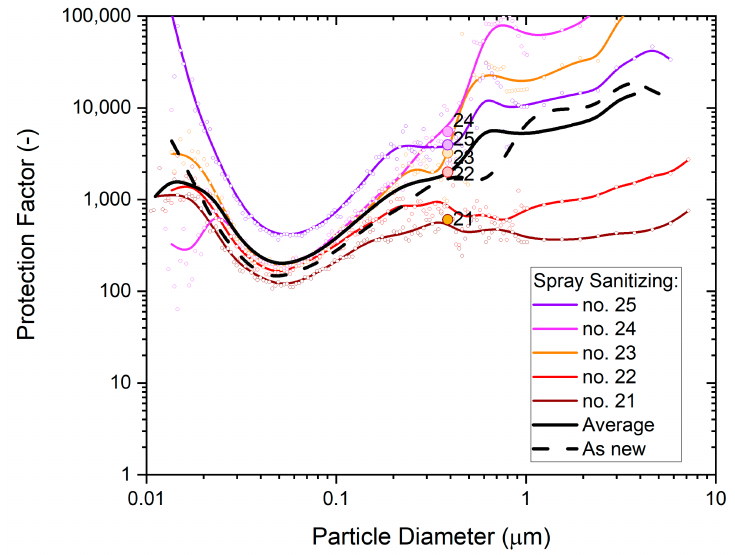
Figure 13. The particle size dependence of the protection factor of five P2-SD disposable respirator masks (Shanghai Da Sheng, box 3) after exposure to vapors from spray sanitizing; results from non-destructive testing are shown as circular dots with corresponding coloring at 0.39 µ m particle size. The average performance is shown by the black solid line and the performance of an unused mask (as new) is shown for comparison by the black dashed